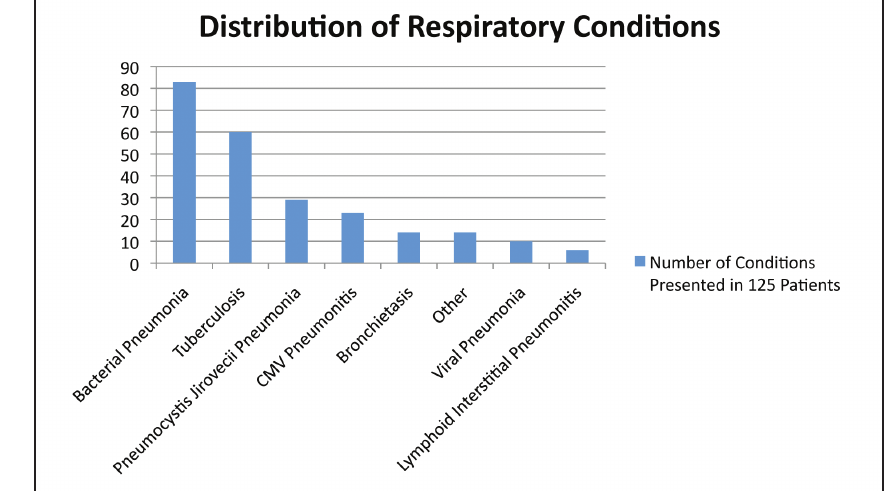
Figure 2: Distribution of respiratory conditions (n=239